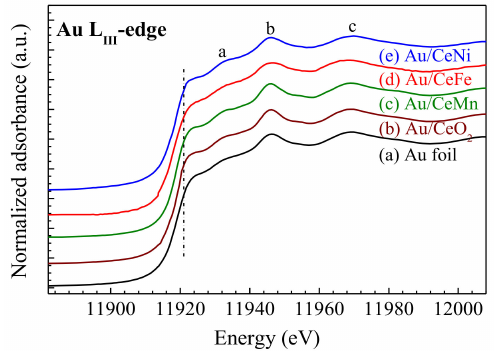
Figure 9. Au L III -edge XANES spectra of the Au catalysts supported on CeO 2 and CeM mixed oxides with different dopants: ( a ) Au foil; ( b ) Au/CeO 2 ; ( c ) Au/CeMn; ( d ) Au/CeFe; ( e )